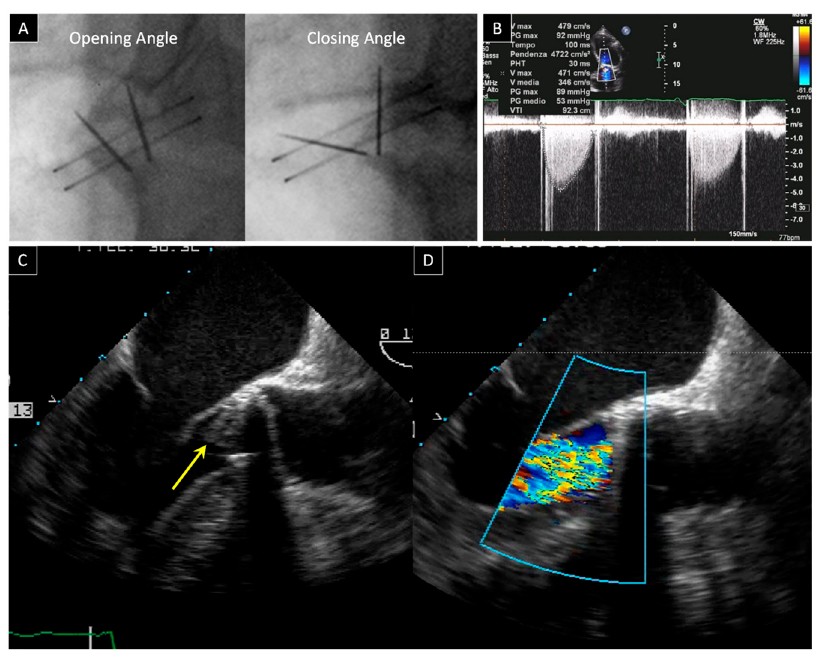
Figure 2. Bileaflet mechanical aortic valve obstruction. ( A ) Fluoroscopy shows normal opening and abnormal closing angles in a patient with prosthetic aortic valve dysfunction. ( B ) Flow acceleration of the anterograde flow is identified with color flow imaging from the TTE apical approach and it is associated with high transprosthetic gradients at continuous wave Doppler ( Δ Pmean 53 mmHg). ( C ) 2D TEE from a 120° view reveals a thrombotic hyperechogenic mass on the ventricular side of the prosthesis (arrow). ( D ) Severe intraprosthetic regurgitation as assessed by 2D TEE.